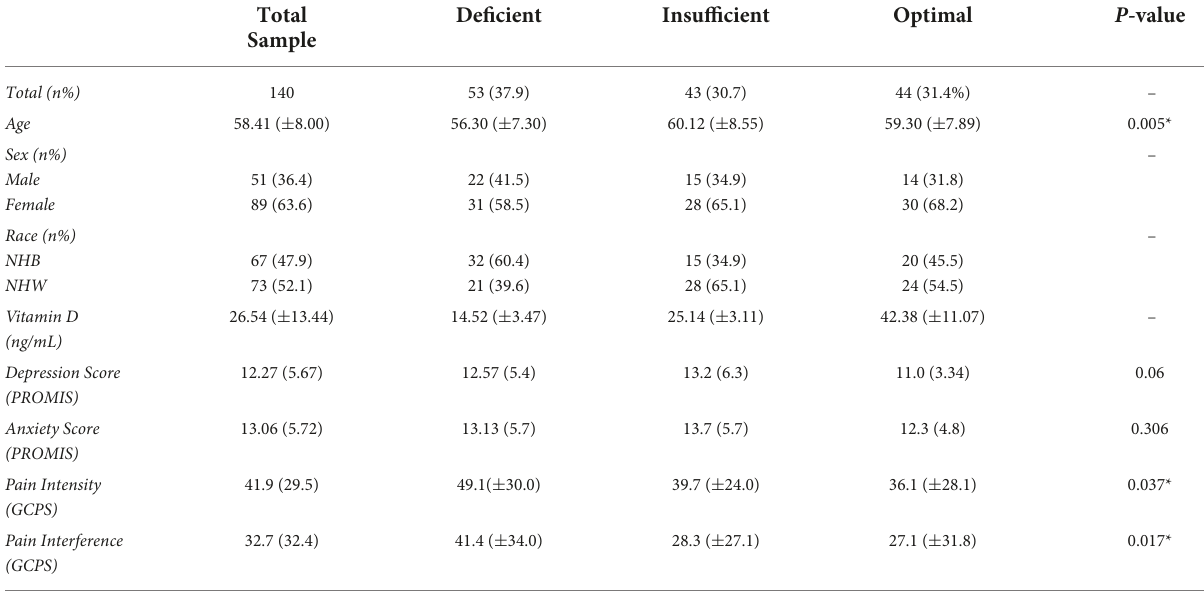
TABLE 1 Characteristics of the sample by vitamin D status